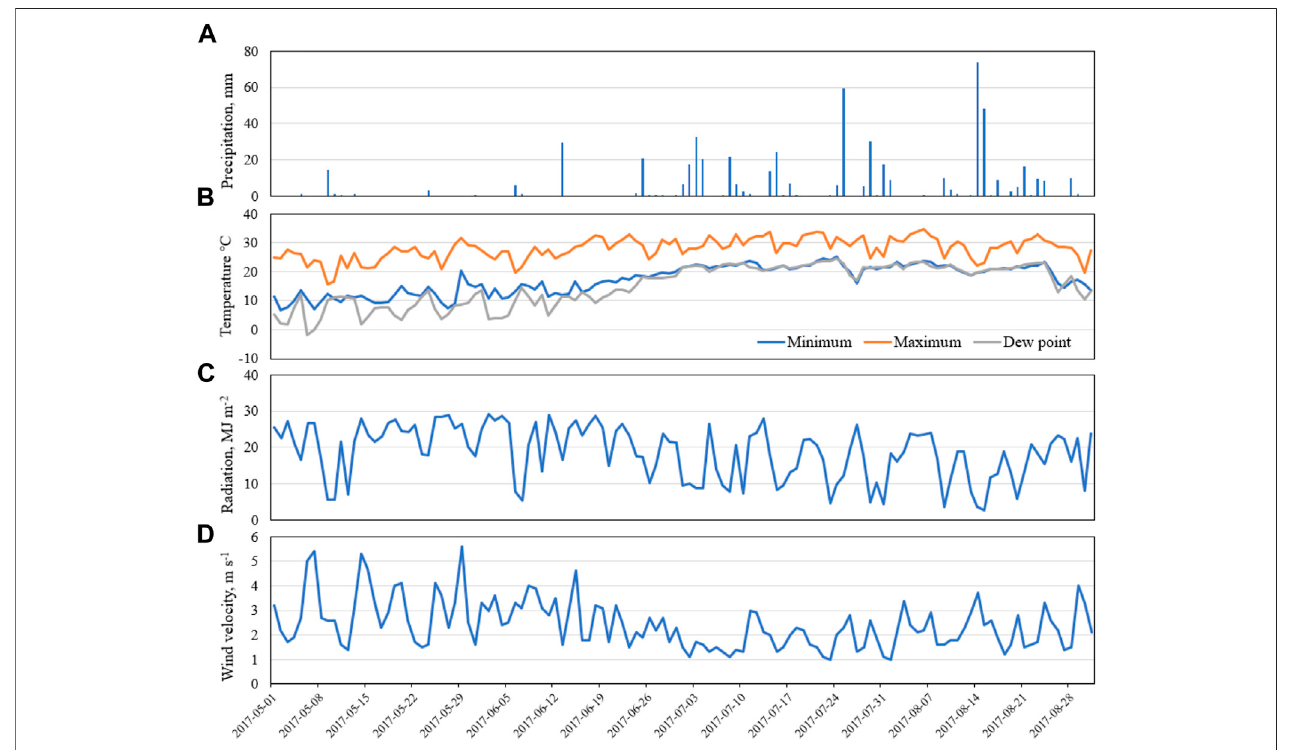
FIGURE3| Dailyweatherdatafor (A) precipitation, (B) minimumandmaximumtemperature,and dewpointtemperature, (C) solarradiation,and (D) dailyaverage wind speed from the Chupungnyeong station (127 ° 99 ′ 46 ″ E, 36 ° 22 ′ 02 ″ N) for inputs in the WEPP model.